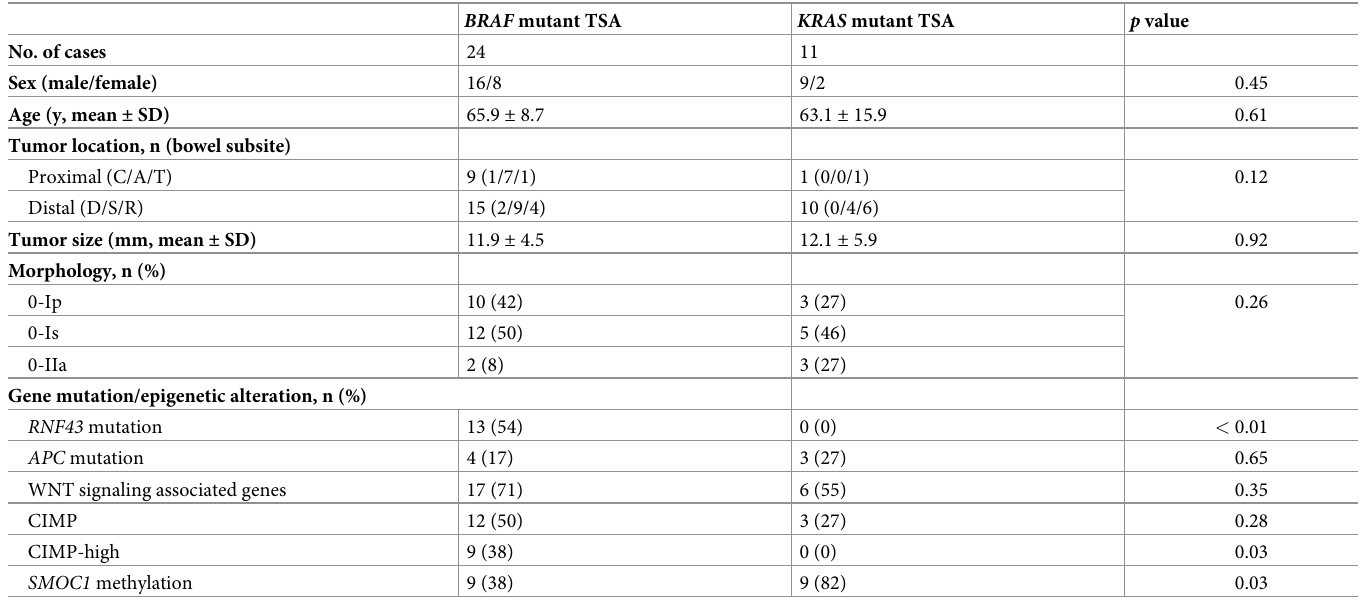
Table 3. Clinicopathological and molecular characteristics of the KRAS - and BRAF - mutant